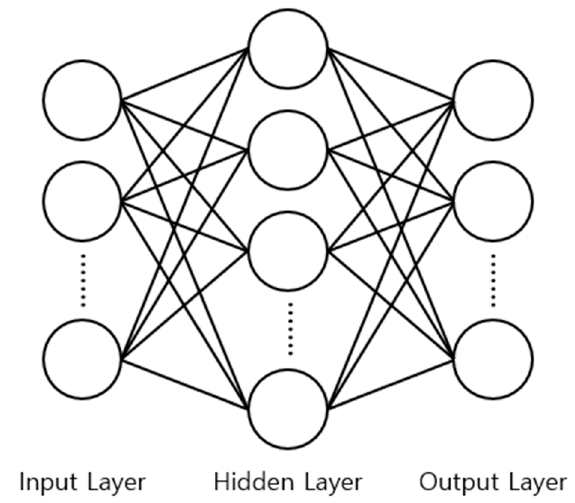
Figure 7. Multilayer neural network architecture.